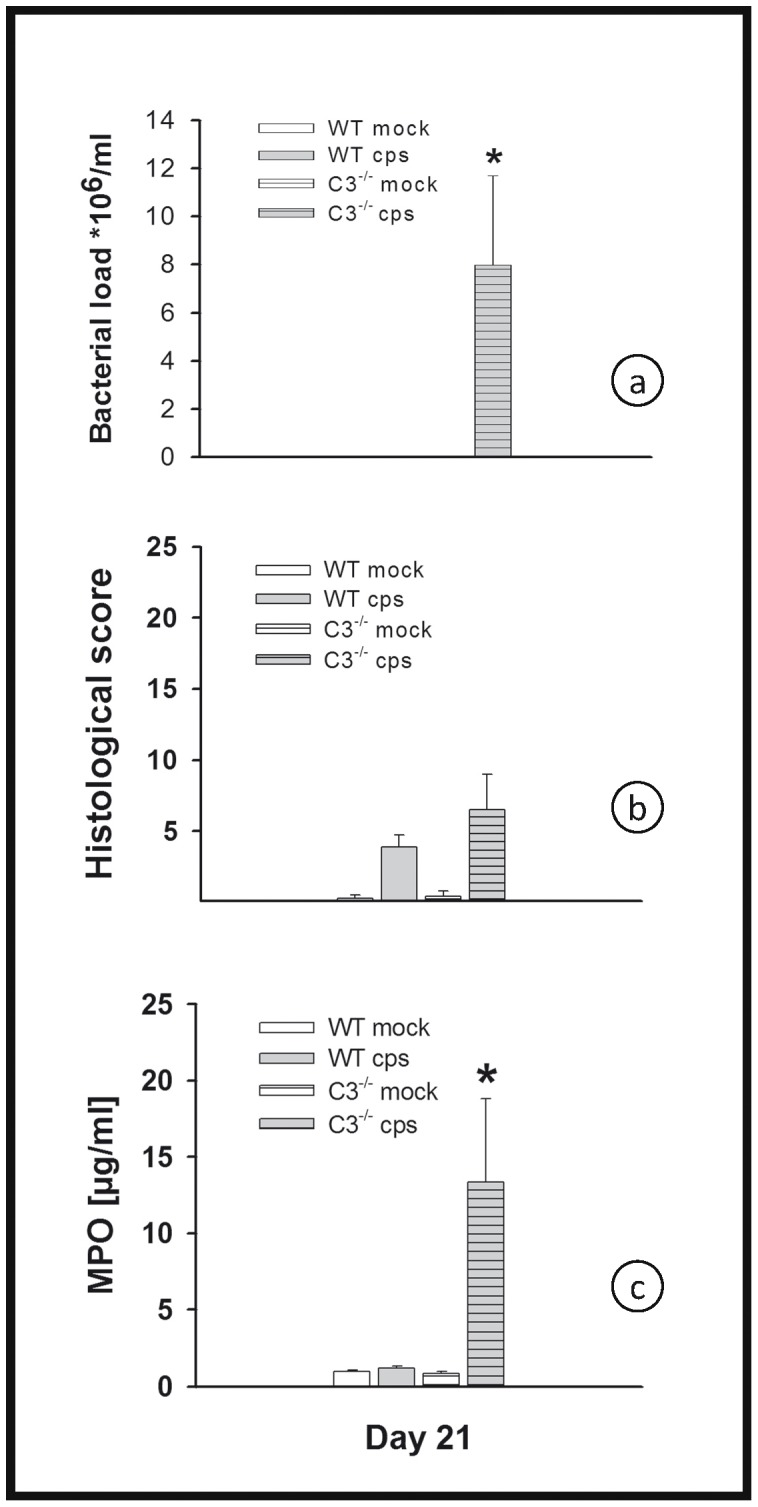
Figure
6. Bacterial load, histological score and MPO in C3−/− and WT mice in low-dose
C. psittaci
 infection. Mice were infected with 200 IFU of C. psittaci DC15 or mock-infected and sacrificed on day 21 p.i. Bacterial load (panel a), histological score (panel b) and MPO (panel c) in C3−/− and WT mice in low-dose C. psittaci infection were determined. The figure shows data obtained from C. psittaci-infected mice (cps, gray bars), mock-infected mice (white bars), WT mice (open bars) and C3−/− (horizontally hatched bars). Means ± SEM are depicted. * indicates significant (p<0.05) differences between infected knockout as compared to the corresponding infected BL/6J WT mice.